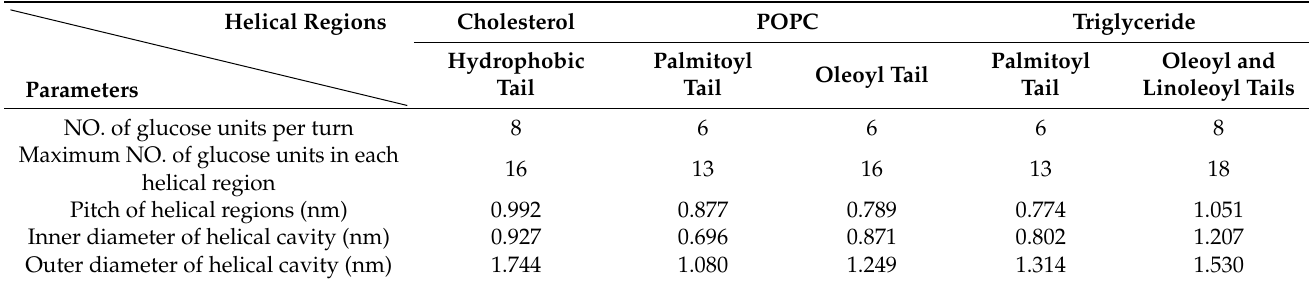
Table 2. Conformation parameters of helical regions of amylose-lipid